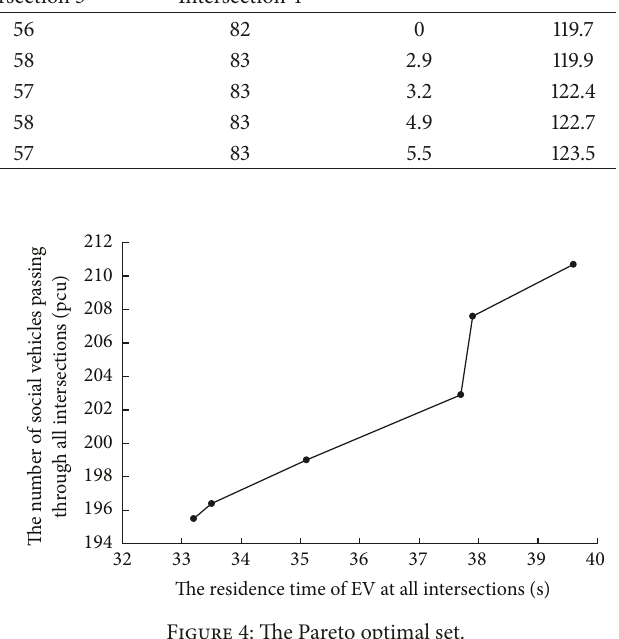
Figure 4: The Pareto optimal